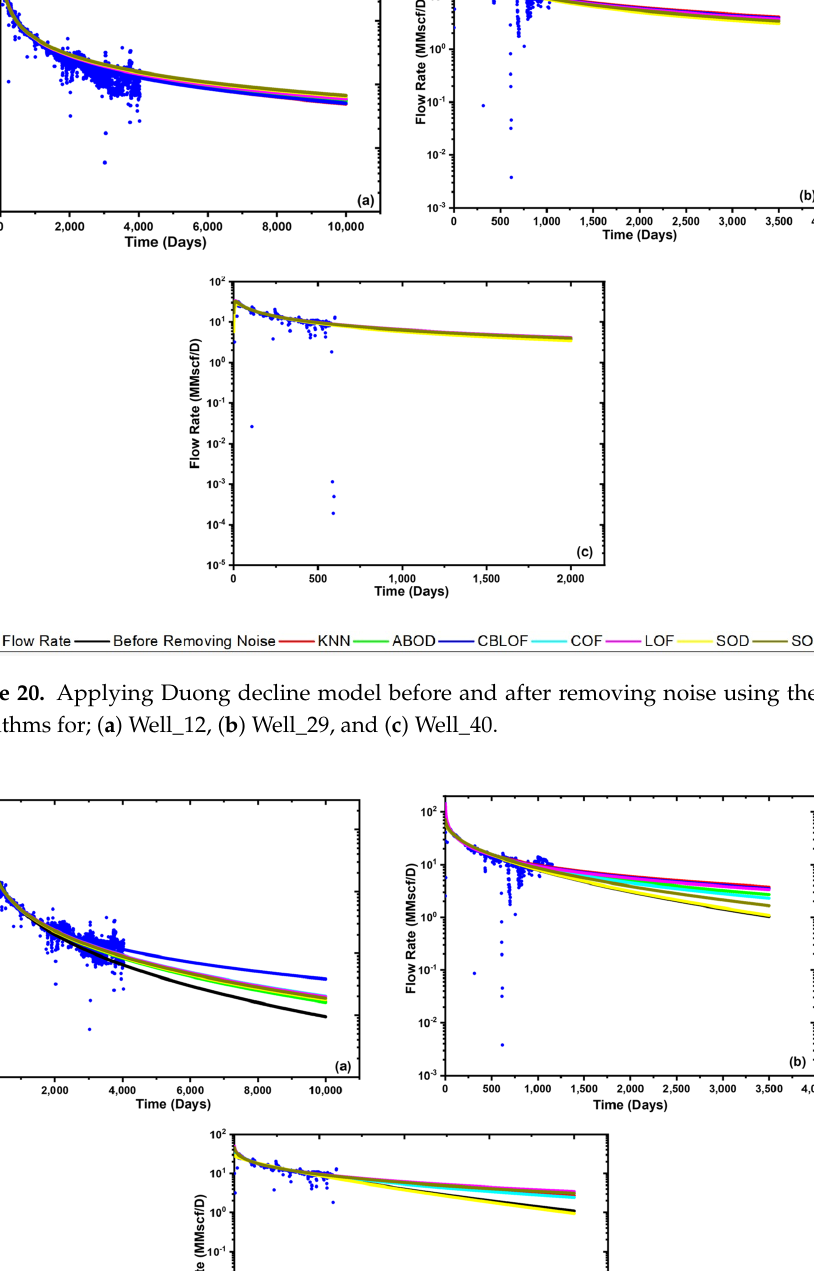
Energies 2022 , 15 , x FOR PEER REVIEW